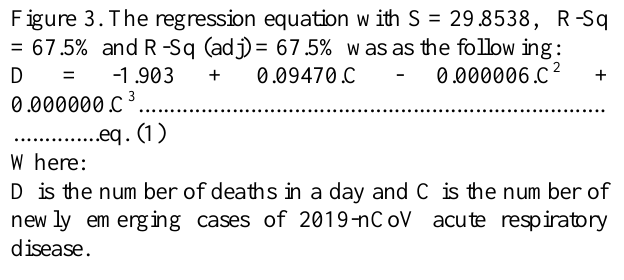
Figure 3. The regression equation with S = 29.8538, R-Sq